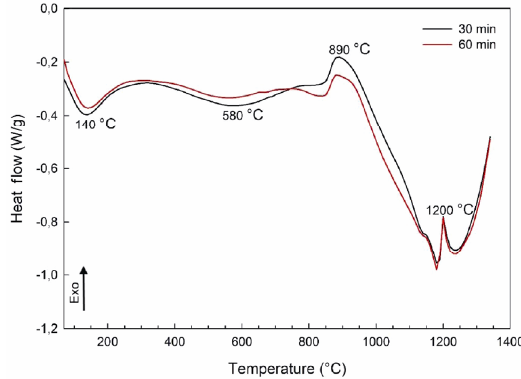
Fig. 4 DSC analysis of mechanically activated powder mixture for 30 and 60 min.